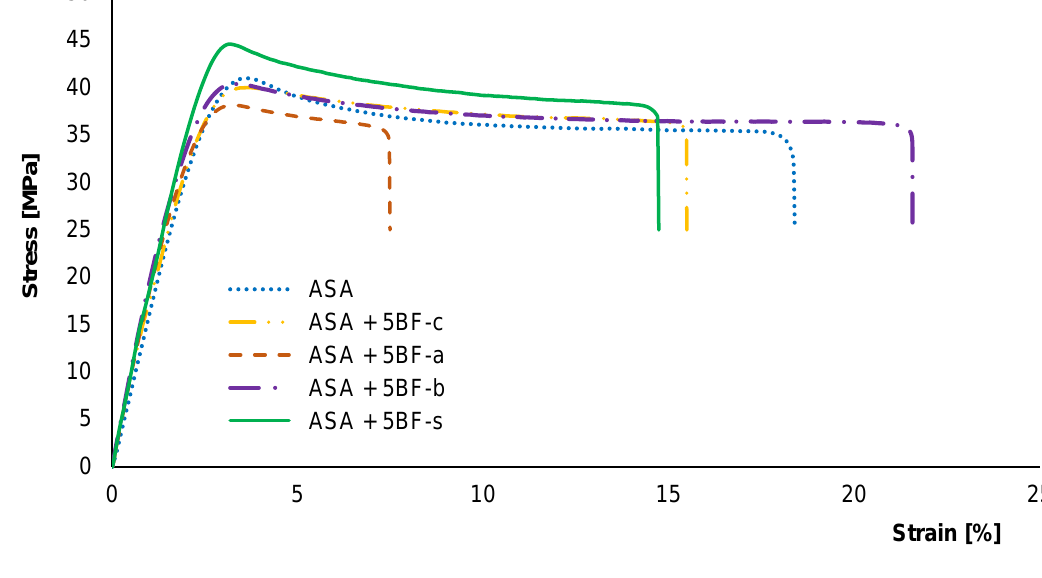
Figure 2. Tensile testing representative stress-strain curves of ASA and composites prepared with 5 wt% of BF after different surface treatments by IM.